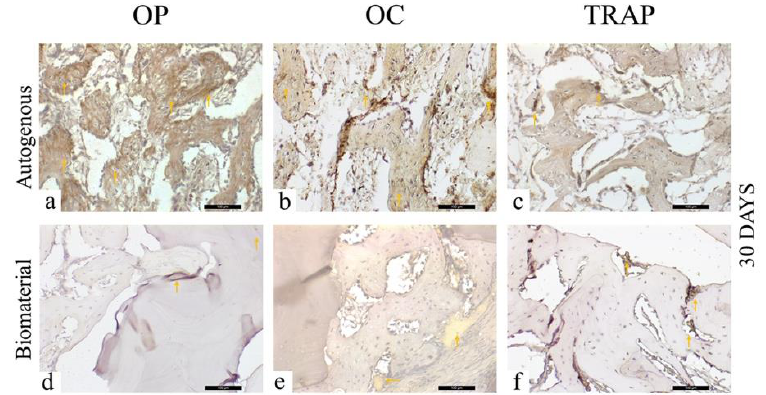
Figure 7. Osteopontin (OP), Osteocalcin (OC), and Tartrate-resistant Acid Phosphatase (TRAP) immunostaining at 30 days for the experimental groups. Immunolabeling is indicated by orange arrows. ( a ) OP immunostaining at 30 days in the AG; ( b ) OC immunostaining at 30 days in the AG; ( c ) TRAP immunostaining at 30 days in the AG; ( d ) OP immunostaining at 30 days in the BG; ( e ) OC immunostaining at 30 days in the BG; ( f ) TRAP immunostaining at 30 days in the BG.